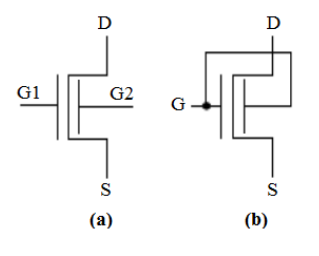
Figure 4. Different Classifications of (a) Independent Gate (IG), (b) Shorted Gate